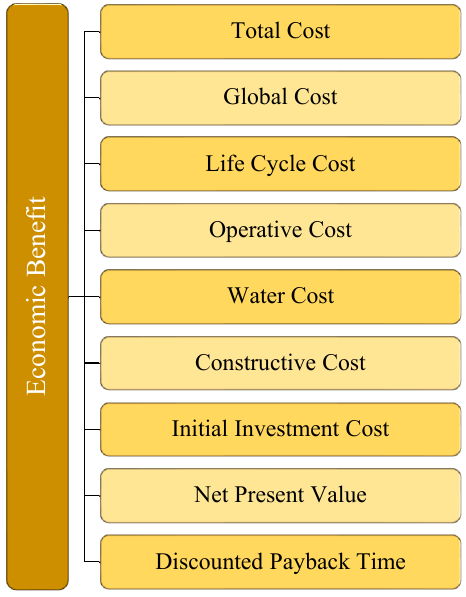
Figure 7. Economic indicators.